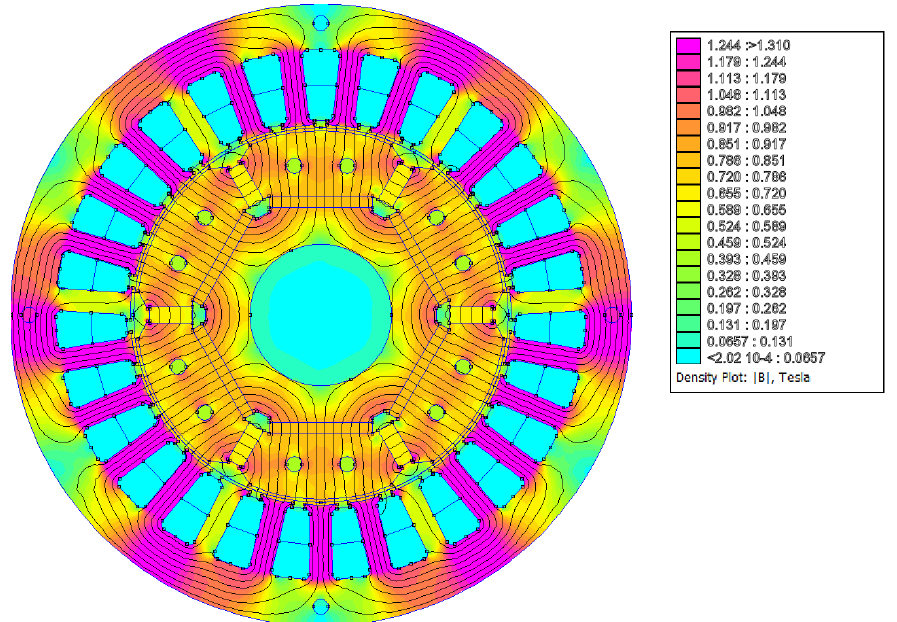
Figure 11. Flux-density distribution from FEM